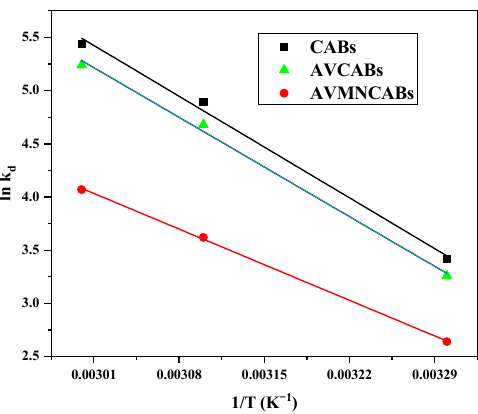
Figure 15. Van’t Hoff’s plot for Cu(II) adsorption. Table 4. Thermodynamic parameters for Cu(II) adsorption on CABs, AVCABs, and